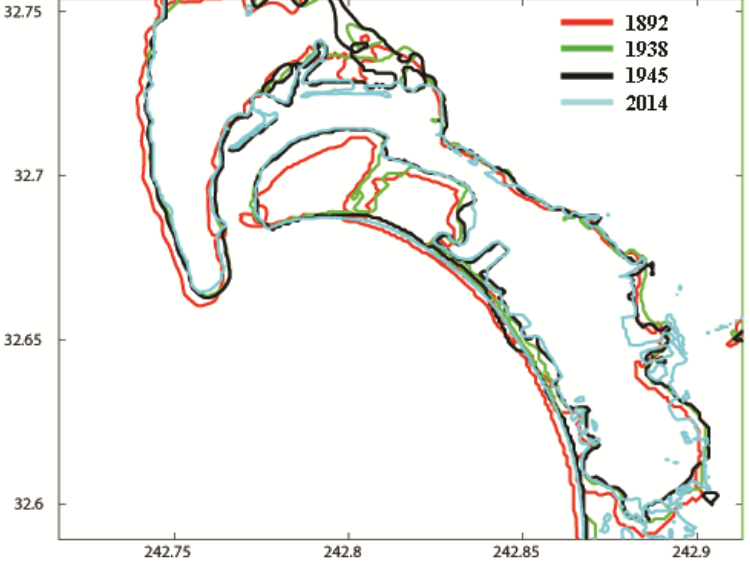
Figure 6. Coastlines of the four digital elevation models (DEMs) used in the numerical